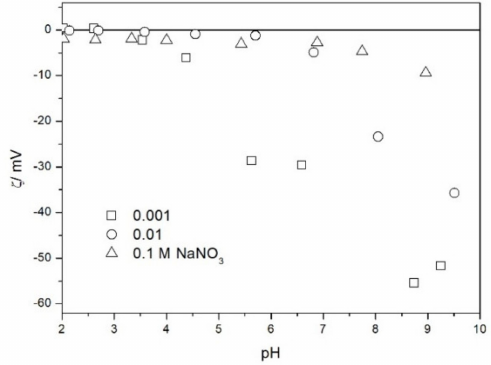
Figure 7. The zeta potential of TeO 2 in NaNO 3